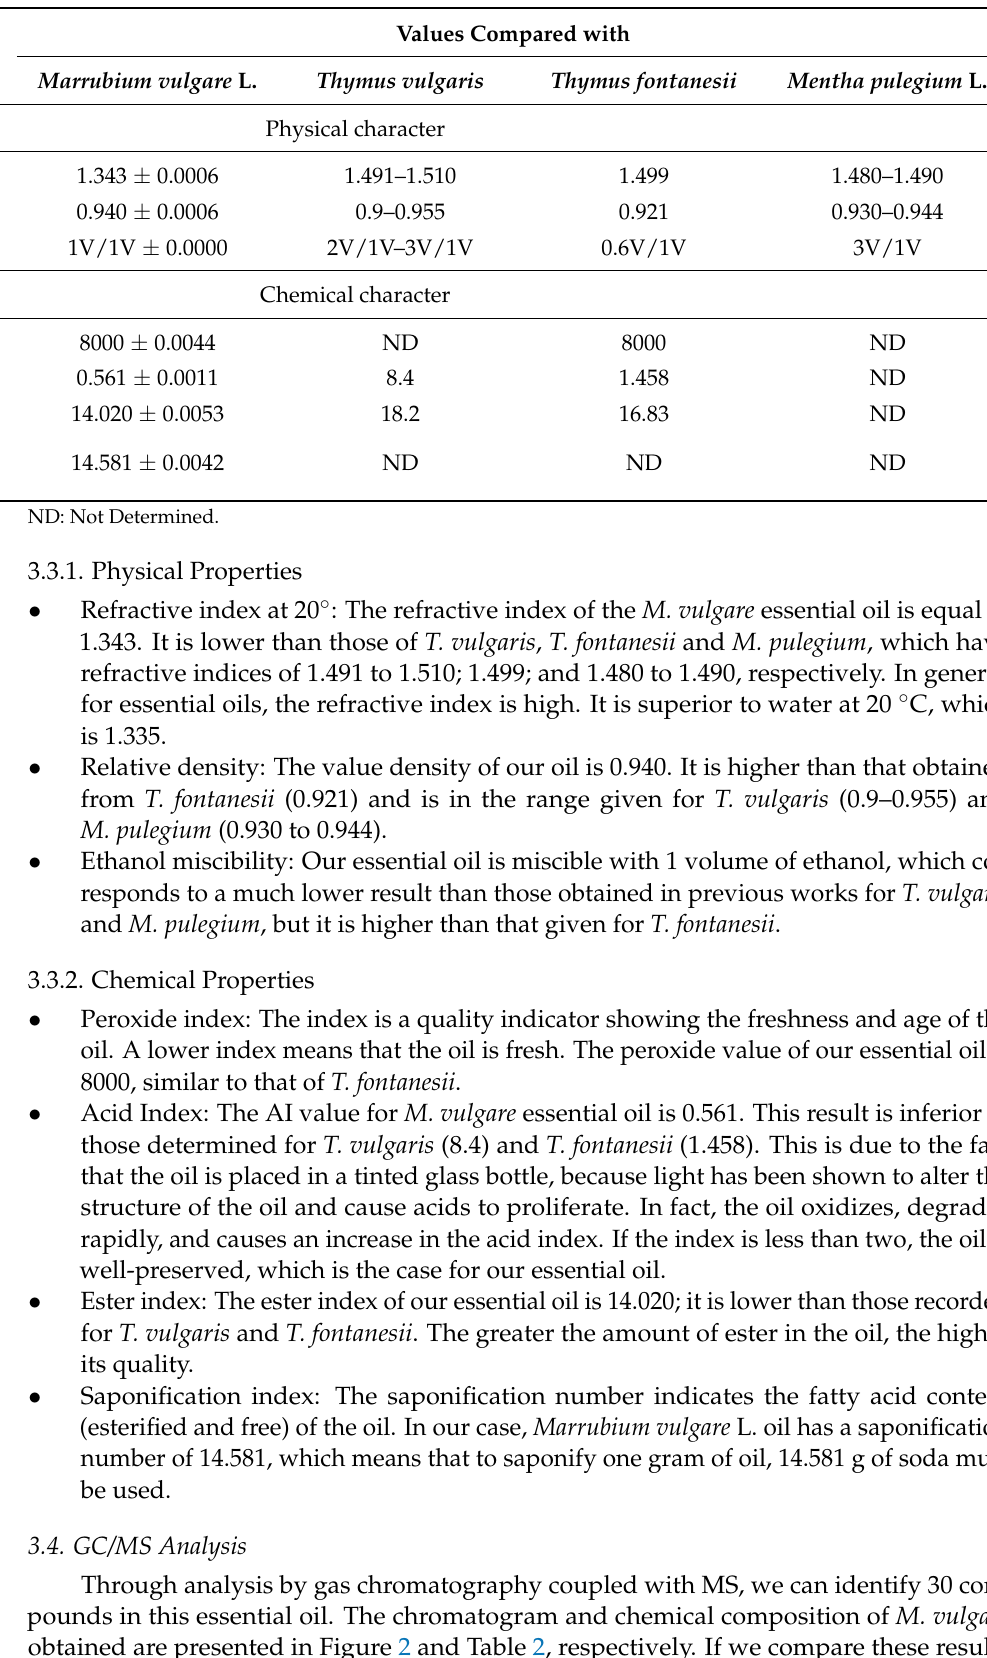
Table 1. Physicochemical indices for essential oil of different